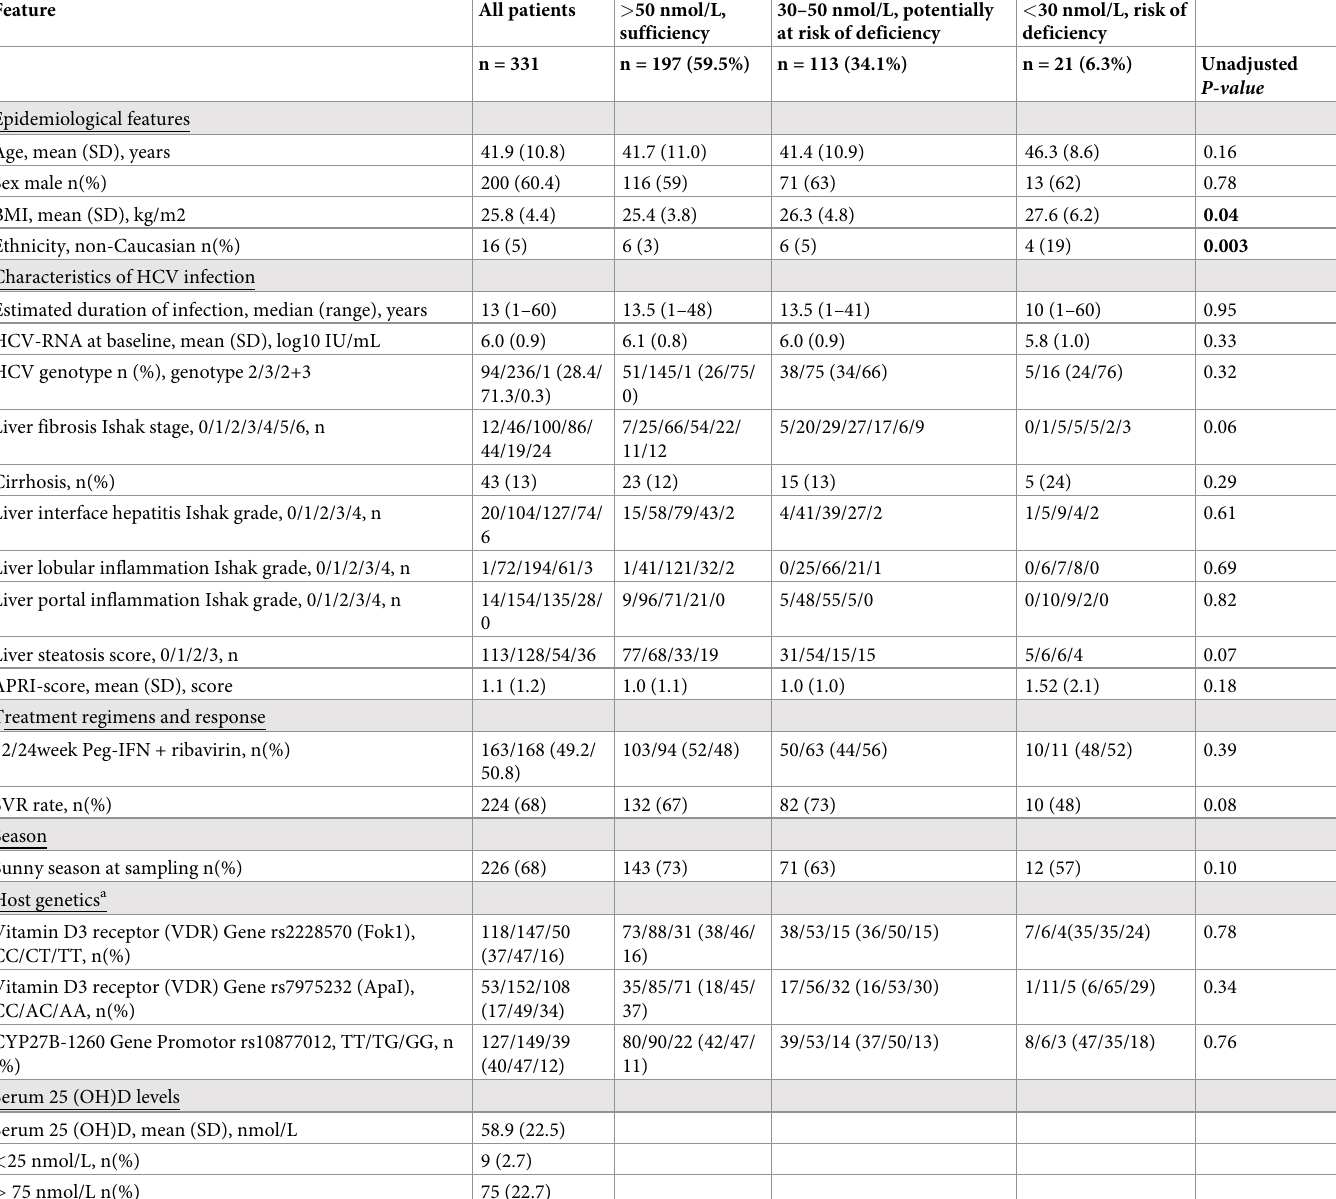
Table 1. Characteristics of the 331 patients included in the study and differences in characteristics according to 25 (OH) vitamin D sufficiency, potential risk of deficiency and risk of deficiency.